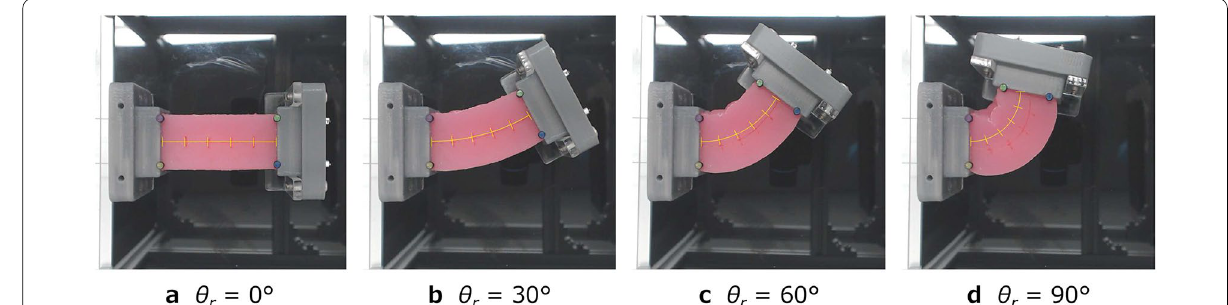
Fig. 7 Pictures of deformation pattern (a) when only l 1 is pulled. The plasticizer is used at 100 wt%. The yellow line indicates the neutral arc line l on the surface of the deformable part predicted by the deformation model. Note that the red line on the surface of the prototype does not match the neutral arc line in the plane where the wires exist because the prototype does not deform uniformly in the Z